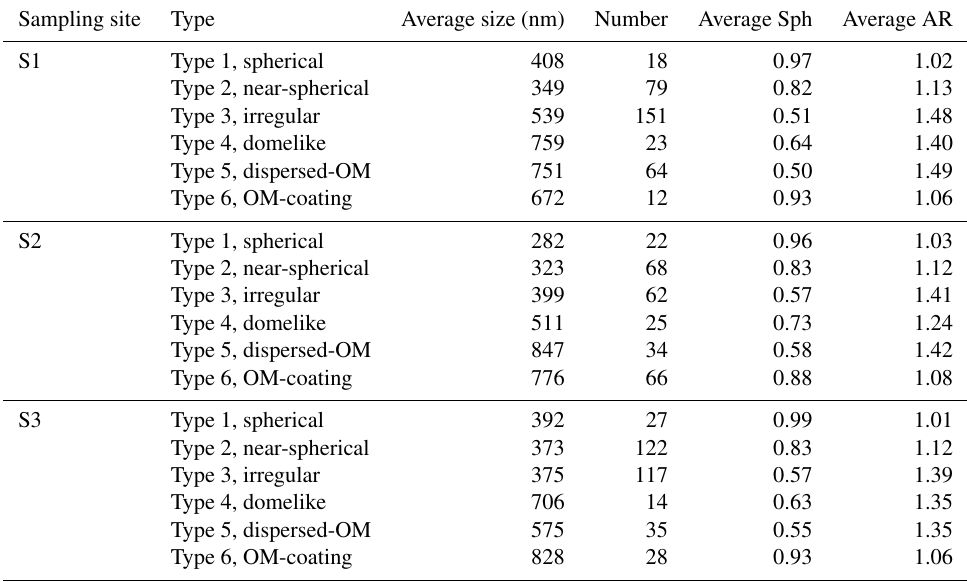
Figure 4. Typical TEM images of different types of OM particles. (a) Type 1: spherical shape; (b) type 2: near-spherical shape; (c) type 3: irregular shape; (d) type 4: domelike OM (droplet-like particle); (e) type 5: dispersed-OM; (f) type 6: OM-coating. Table 1. Average size, number, sphericity, and aspect ratio for different OM types at the three sampling